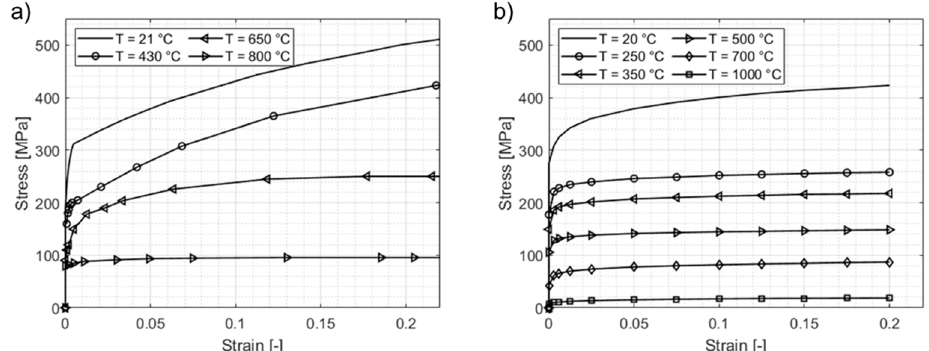
Figure 6. Temperature-dependent stress–strain curves for ( a ) AISI304 and ( b ) S275JR.